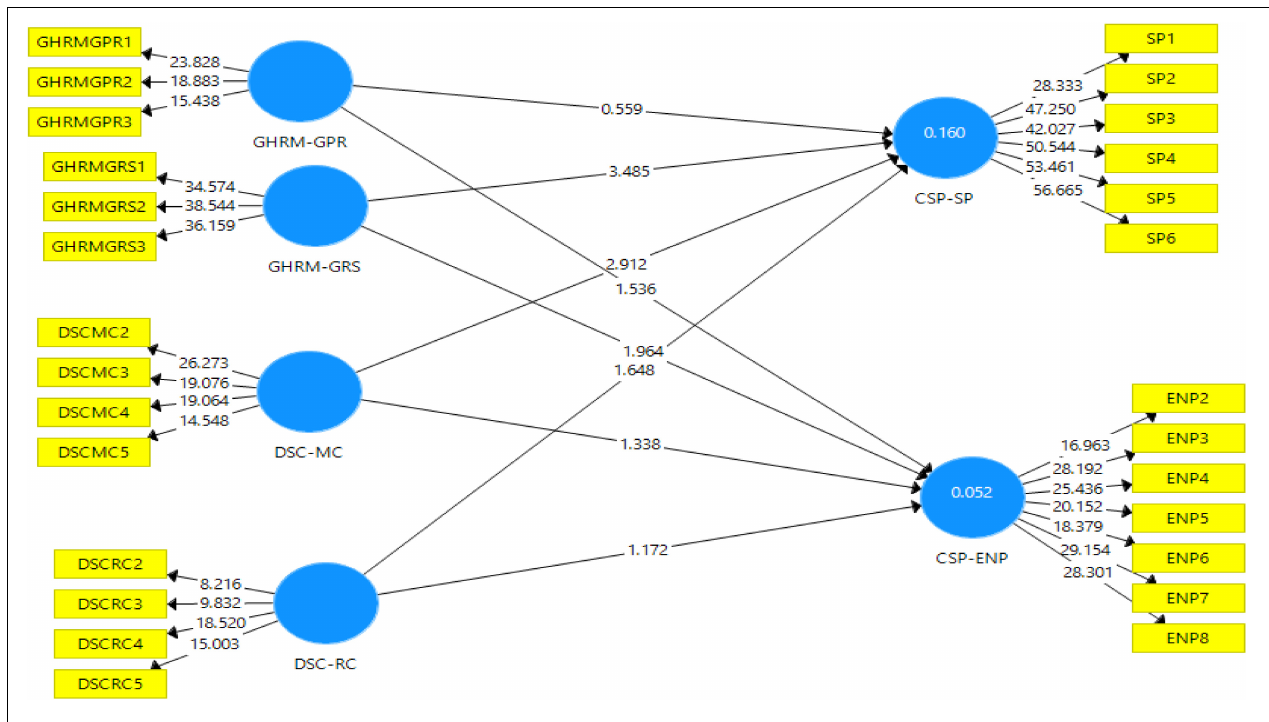
FIGURE 4 | Structural model after bootstrapping.